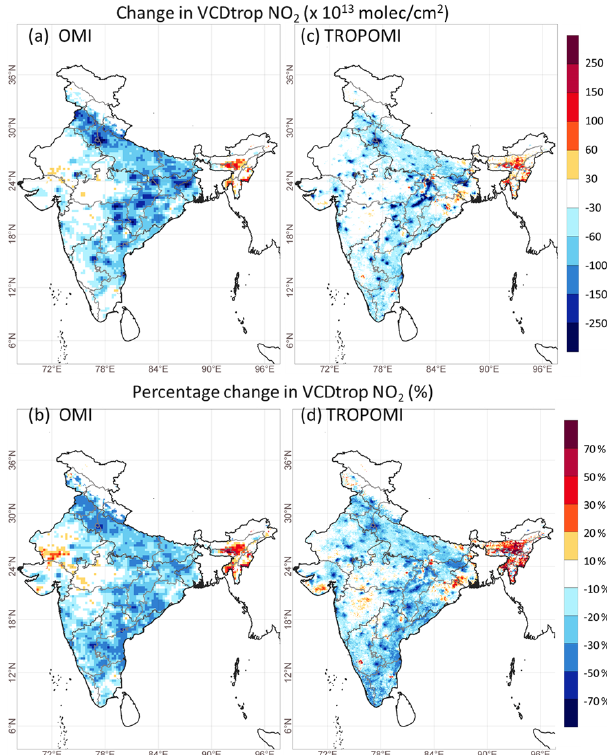
Figure 4. (a, c) Absolute change and (b, d) percentage change in VCD trop NO 2 during the analysis period for LDN year compared to BAU years as observed by OMI (a, b) and TROPOMI (c, d)